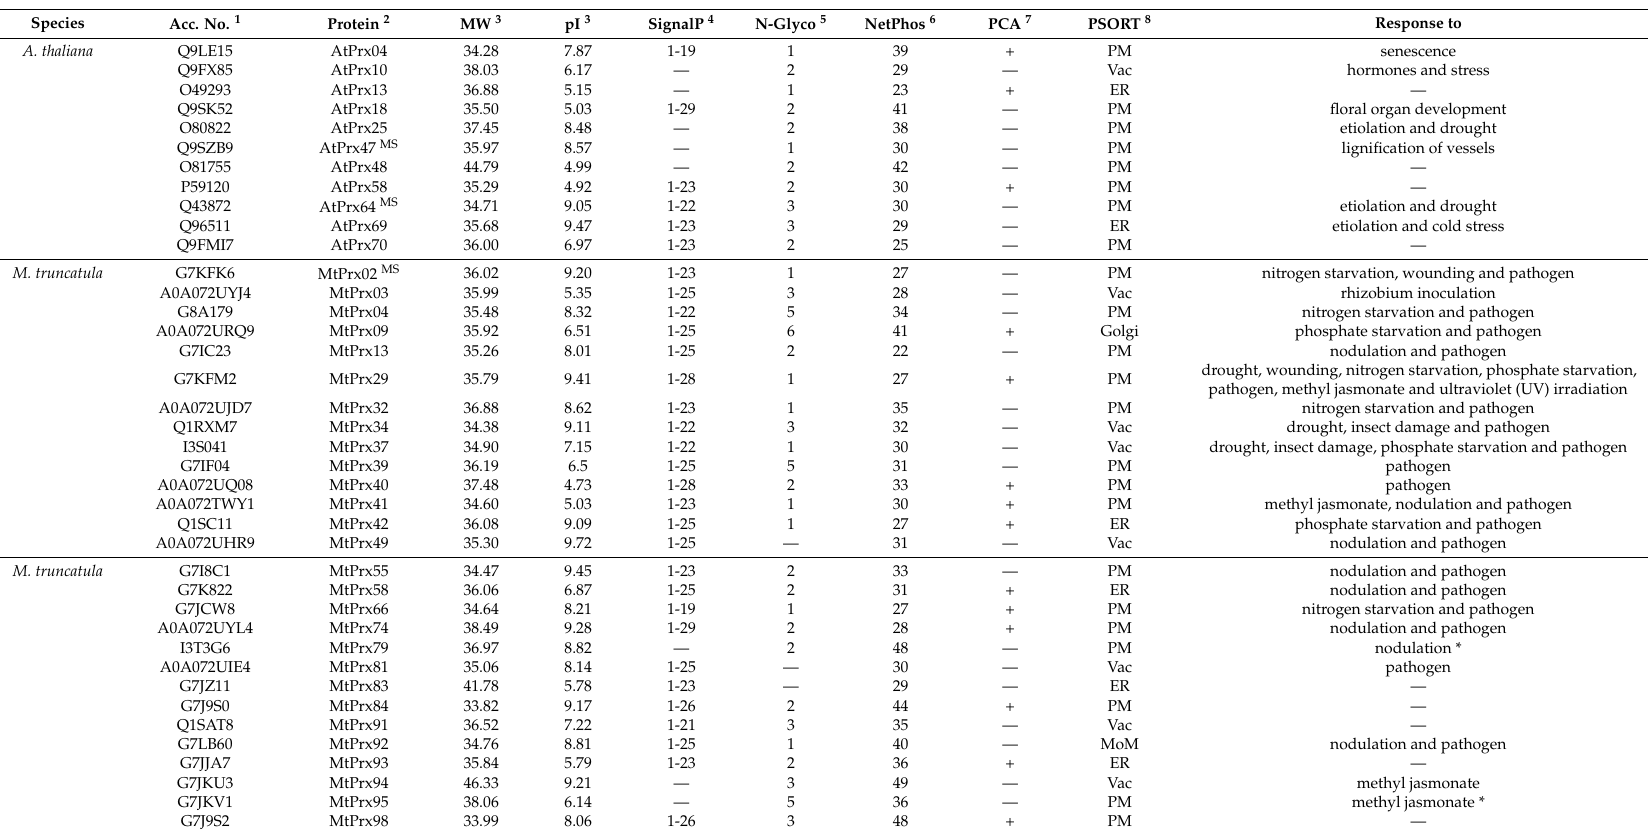
Table 1. Properties and physiological functions of membrane-bound class III peroxidases of arabidopsis, barrel medic, rice and maize. After identification of peroxidase sequences with trans-membrane domains [44], signal peptides [45], post translational modifications [46] and localisation [47] of proteins have been further analysed by bioinformatic tools. In case of missing experimental data on biological functions these have been predicted by a Basic Local Alignment Search Tool (BLAST) (*) search against all peroxidases (inclusive soluble isoenzymes) with highest sequence similarity and known function. ER, endoplasmatic reticulum membrane; Golgi, golgi apparatus; MoM, mitochondrial outer membrane; MS, identified by mass spectrometry [14]; MW, molecular weight; pI, point isoelectric; PM, plasma membrane; PSORT, protein subcellular localization prediction tool; Vac., vacuole. Predicted pyrrolidone carboxylic acid (PCA) modification